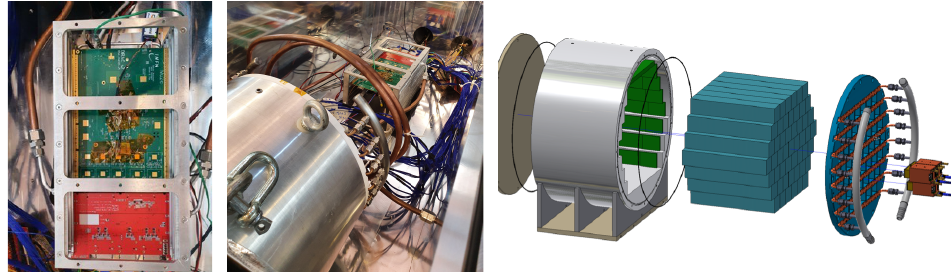
Figure 10. Centre : VST setup with Module-0 and electronics crate. Left : detail of MB and DiRAC installed in the electronics crate. Right : Module-0